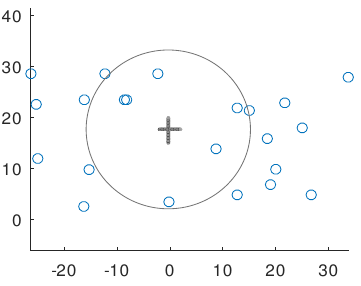
Figure 5. The constrained optimization model (the specific time t ) of finding a circle in 2D that is closest to all cell phone 20 position